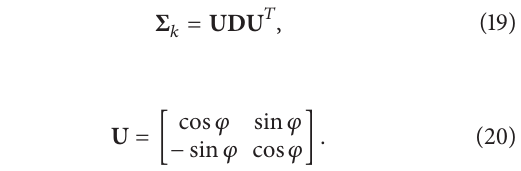
example was chosen because the model assumptions are satisfied. In addition to damage detection, the objective is to test the model identification performance and the number of components selected by the